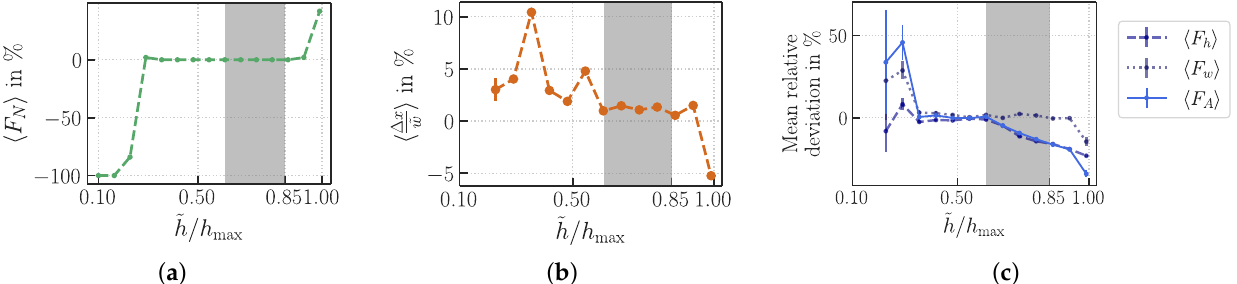
Figure 12. Analysis of the deviation of the height h , the width w and the area A of one wedge in simulated thermogram, averaged over n = 50 trials for each relative height value ˜ h / h max . The CNR stays constant at a value of 11. ( a ) shows the mean relative deviation of the number of detected wedges (cid:104) F N (cid:105) over the relative true wedge heights ˜ h / h max . The mean normalized ∆ x (cid:105) over the true relative heights ˜ h / h max of the wedges is shown in ( b ). The relative deviations of the height, position error (cid:104) ˜ w the width and the area are shown in ( c ). The grey region indicates relative heights commonly found in real thermograms, i.e., 0.73 ± 1 σ , with 1 σ = 0.12. The error bar indicates the standard deviation of the